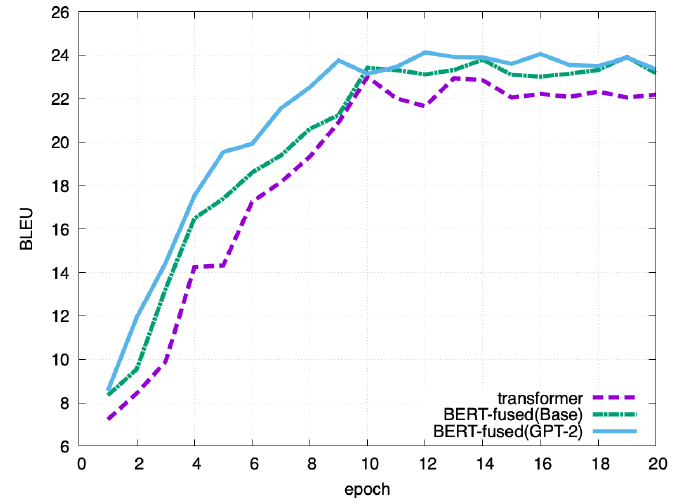
Figure 9. Results of the WMT18En-Ch experiment. Table 3. A comparison table of the results of our experiment and those of other papers (shown with citations). Back-translation of WMT14En-De was conducted using the same amount of data generated by GPT-2. The experimental results examining tatoebaEn-Ja used 100,000 data points for back-translation. All other results are from experiments using the same parameters as in other